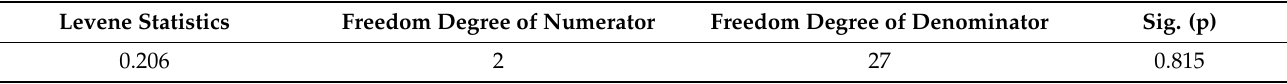
Table 9. One-way ANOVA of the time spent on wayfinding tasks for three different age groups. Items Sum of Square Freedom Degree Mean Sum of Squares F Sig. (p) Between Groups Within Groups Compared significance under the 0.05 level is indicated by